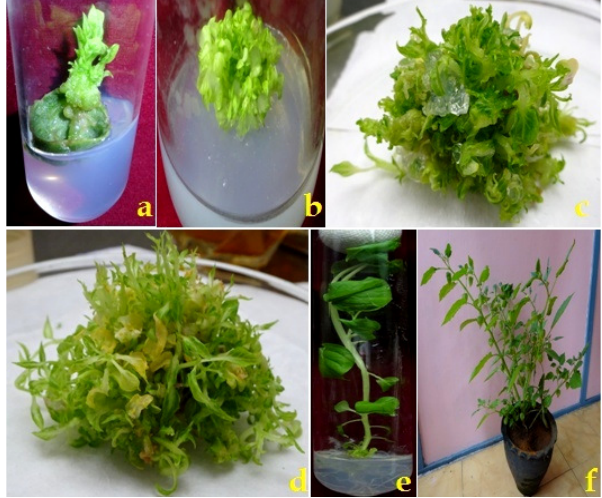
Fig. 1. Direct in vitro micropropagation of Physalis angulata L. using leaf disc explants; (a) Direct induction of multiple shoots at the cut ends of the leaf disc; (b, c & d) Proliferation of multiple shoots at first, second and third subcultures, respectively, on MS + BAP (1.0 mg/L) + IAA (0.50 mg/L) + GA (0.20 mg/L); (e) rooting in vitro grown plantlet in MS + 3